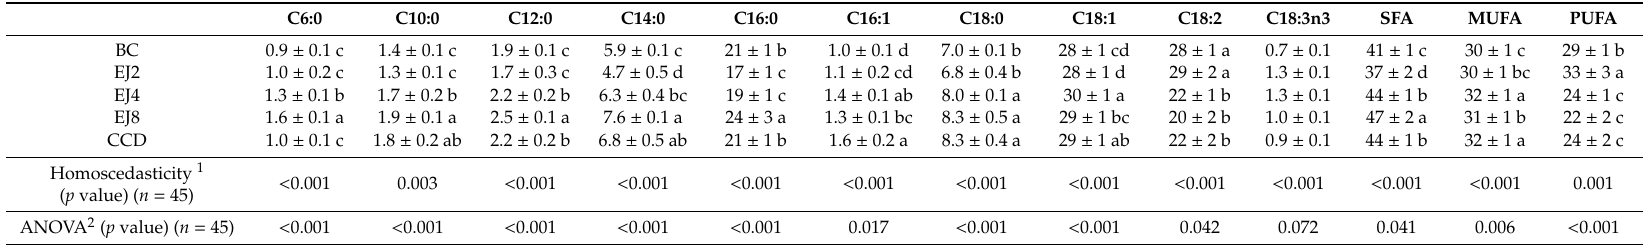
Table 3. Fatty acid profiles of the di ff erent croissant formulations (relative